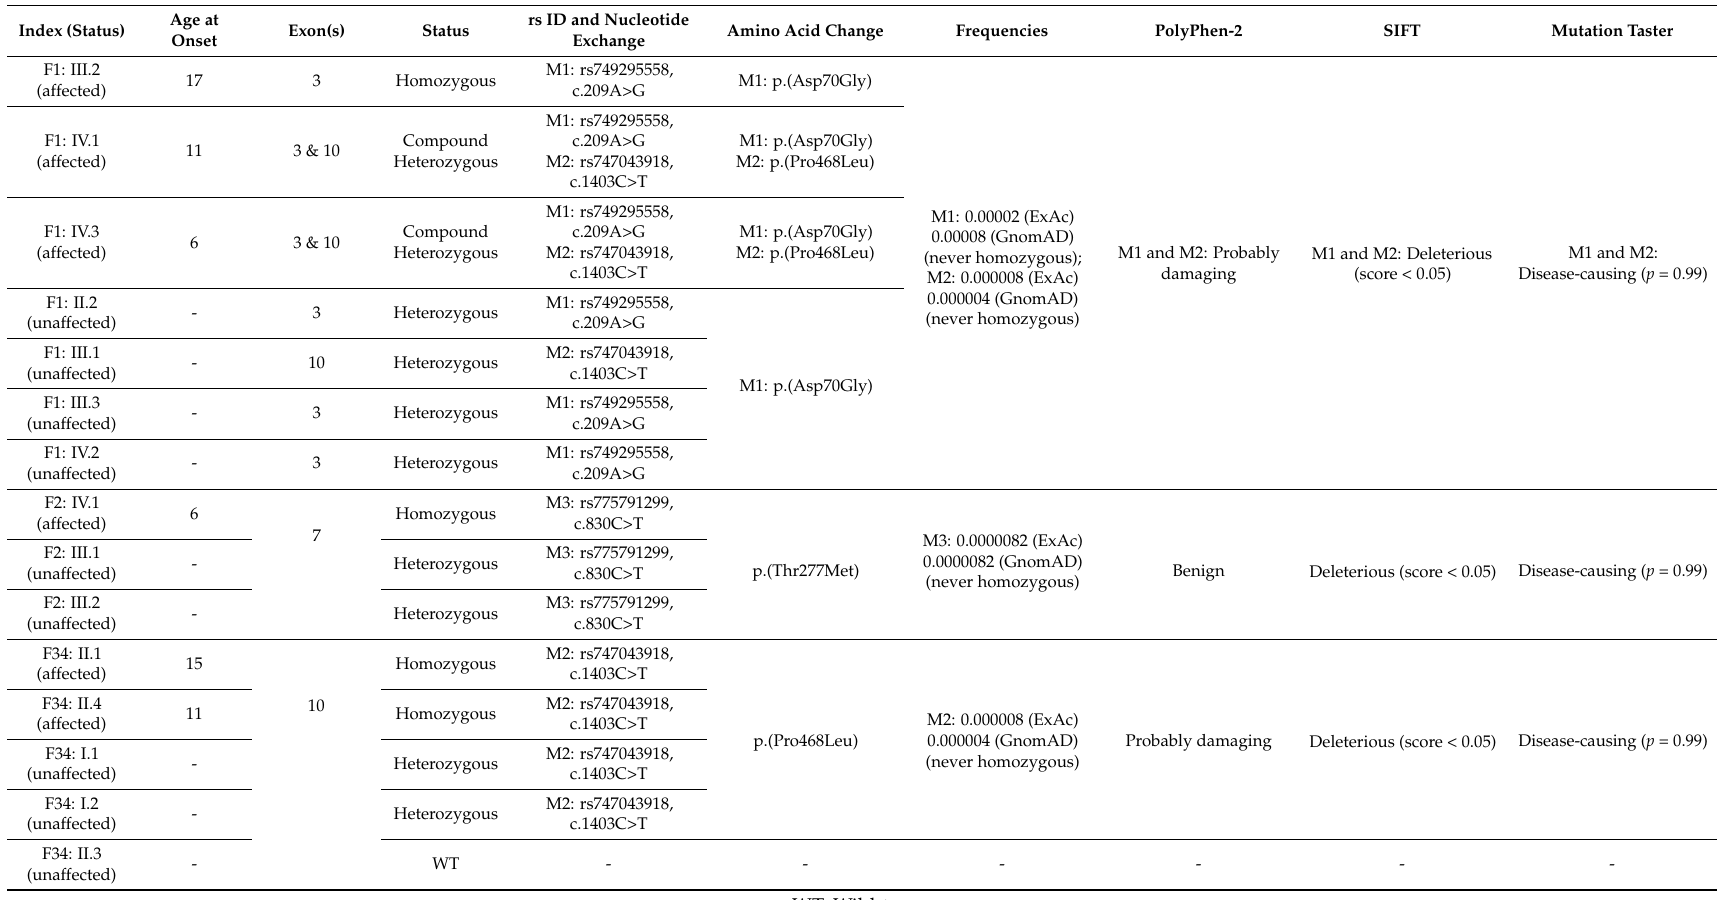
Table 2. BEST1 mutations identified in three Lebanese